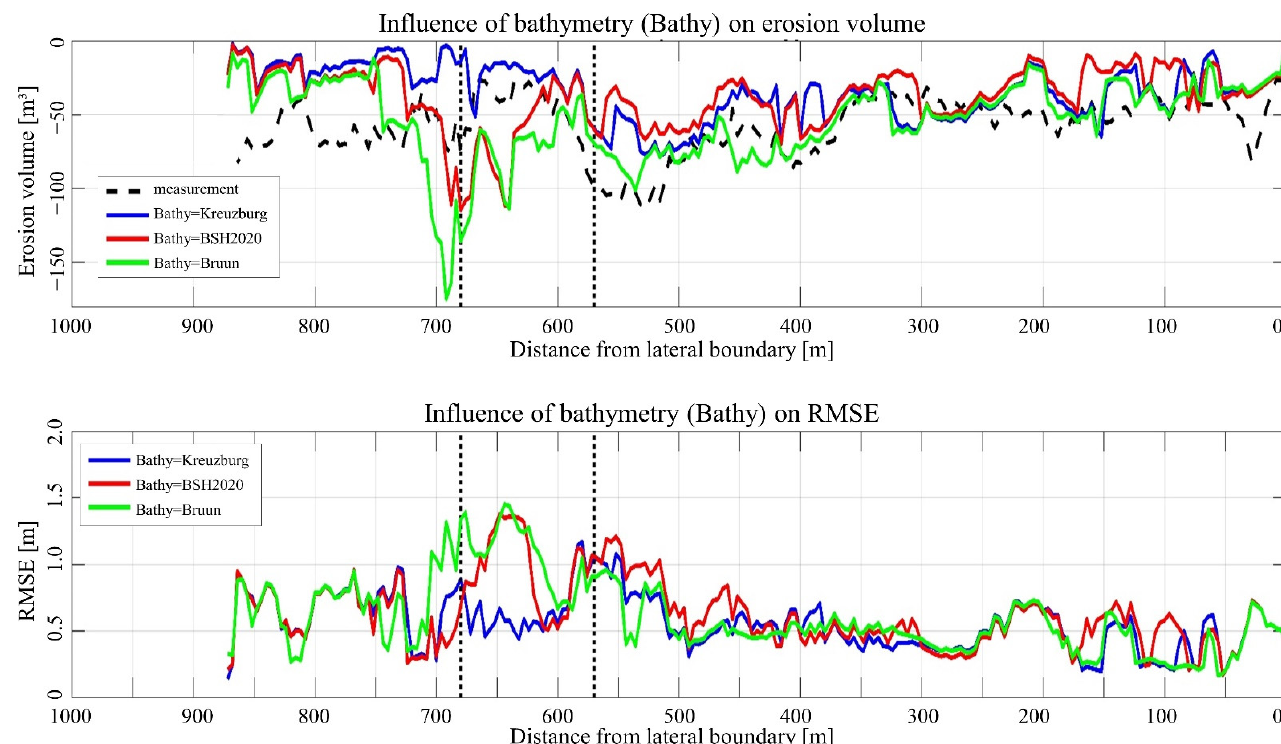
Figure 23. Influence of the nearshore bathymetry on the erosion volume and statistical parameter RMSE, Huetelmoor.